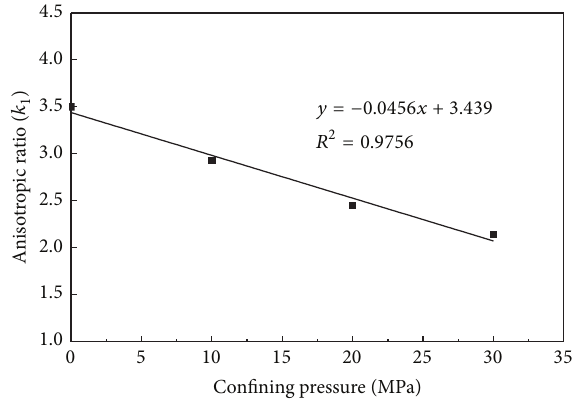
Figure 6: The relationship between anisotropic ratio 𝑘 1 and the con- fining pressure.